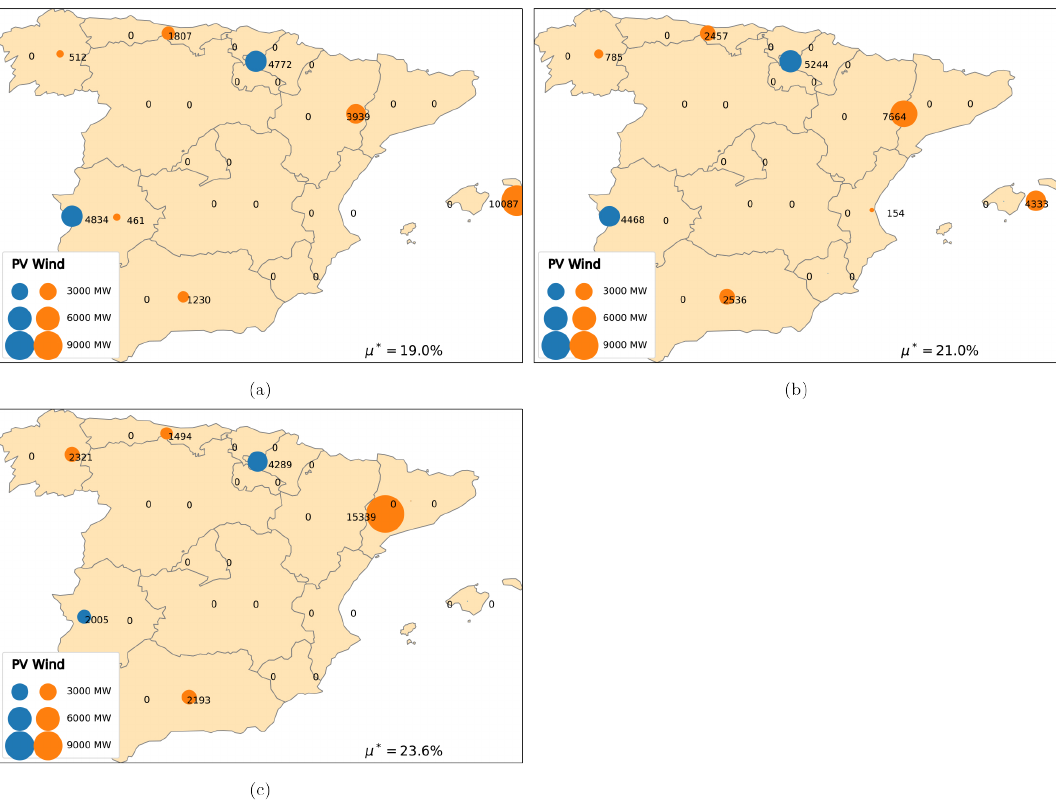
Figure 9. NEW/CAL ( a ) low-risk mix, ( b ) high-penetration mix and ( c ) free high-penetration